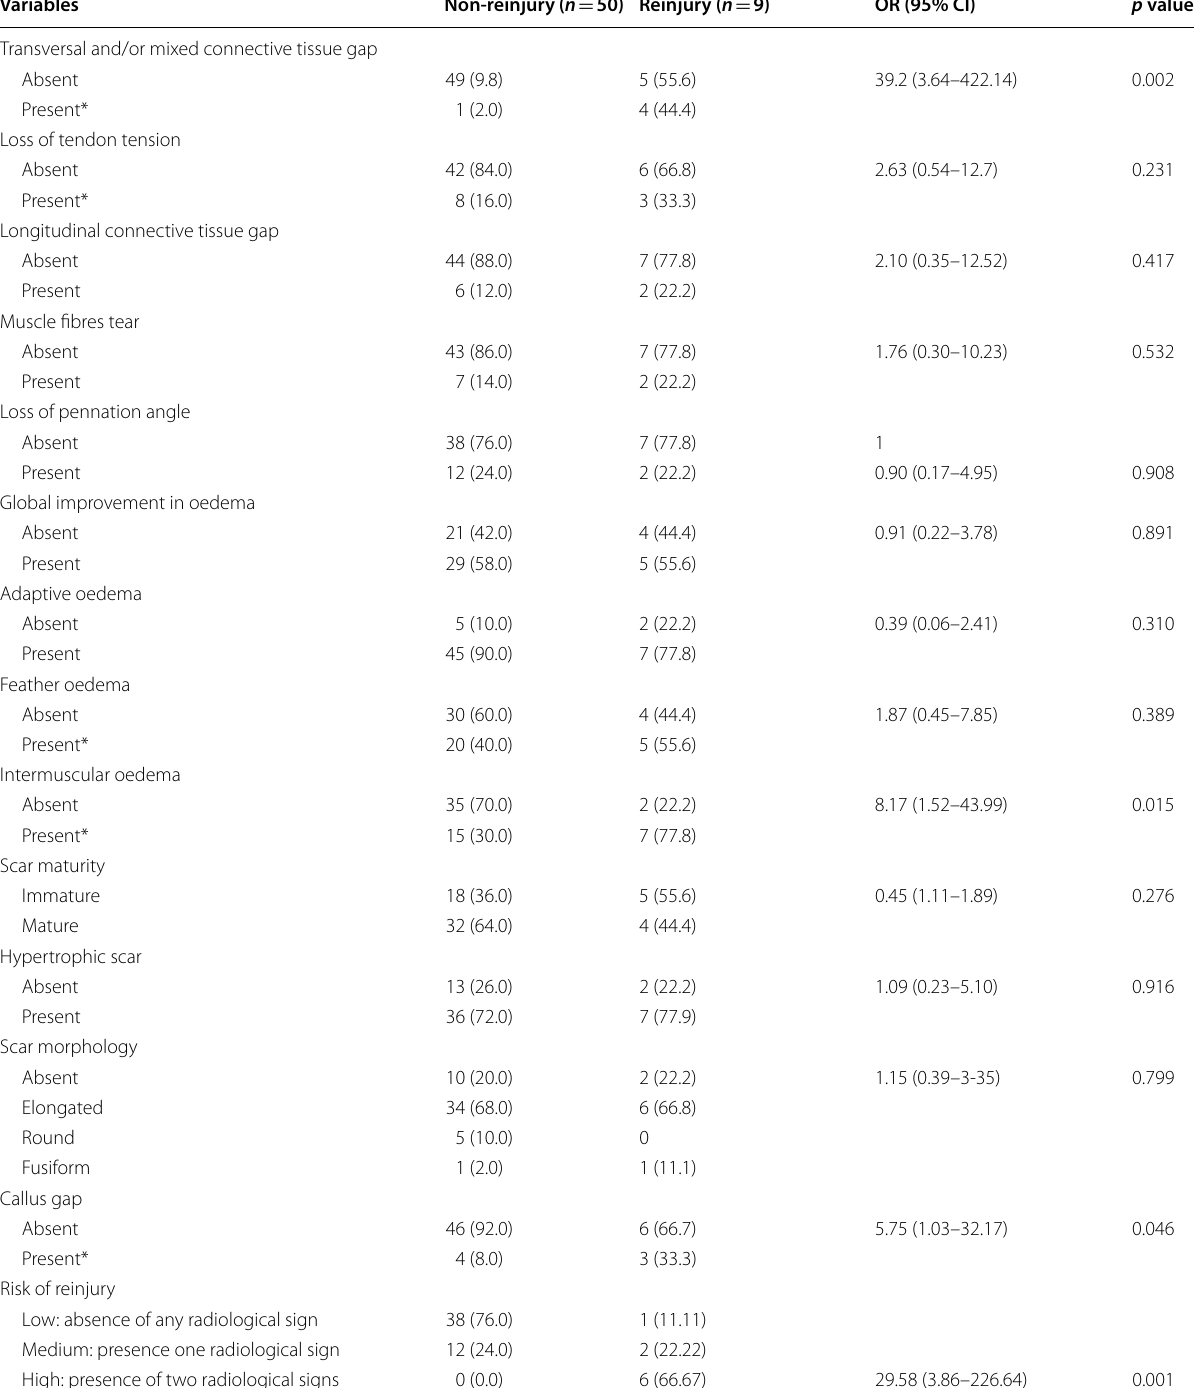
Table 4 Differences in control MRI findings (within 7 days prior to return to play) between professional athletes with and without